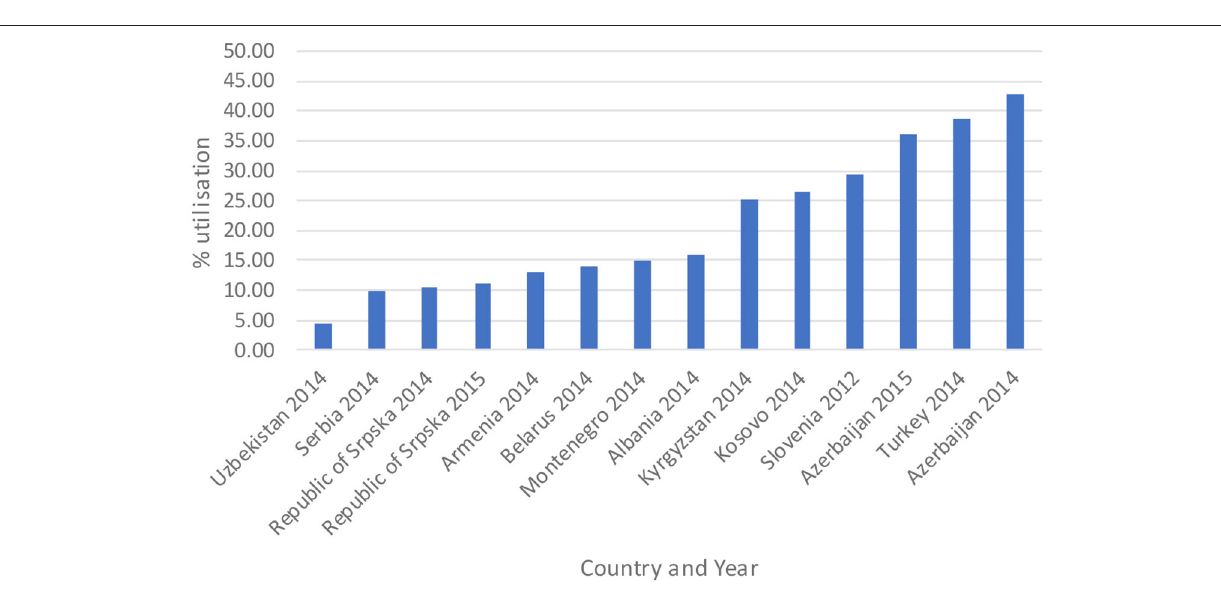
causing concern with increasing resistance rates as well as side- effects with the macrolides (Albert and Schuller, 2014; ECDC,